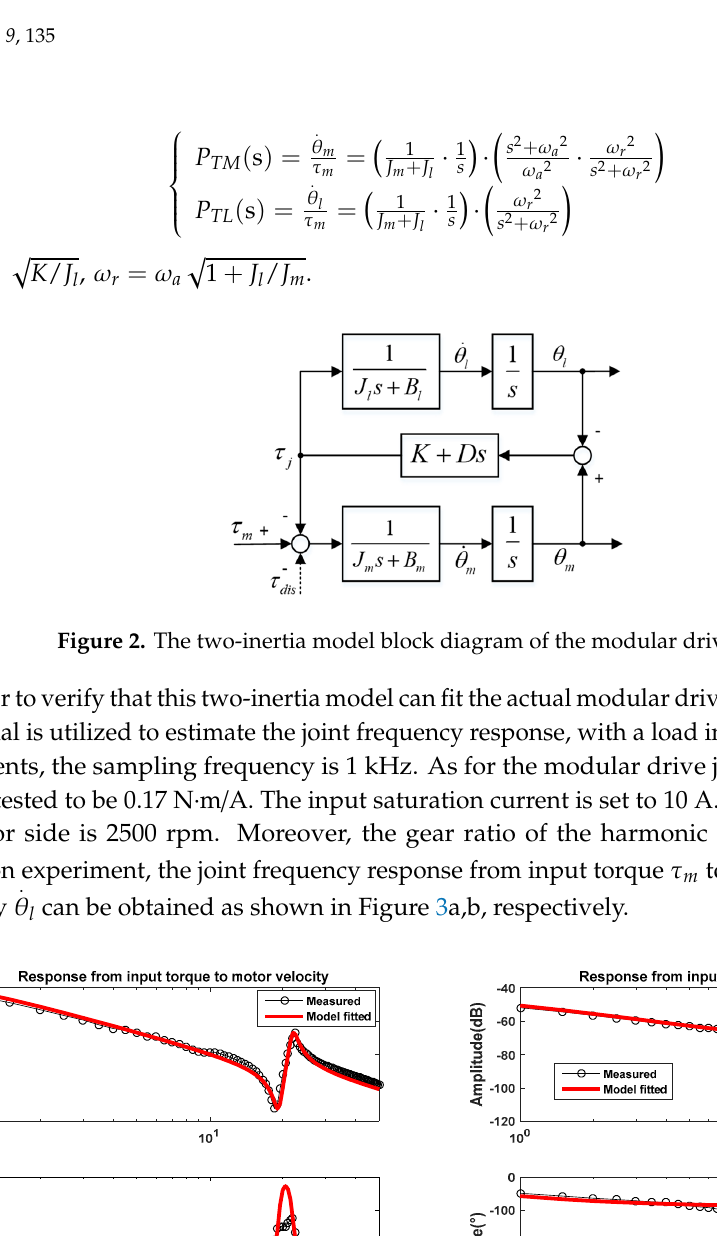
. θ  . τ to τ θ l m m to l